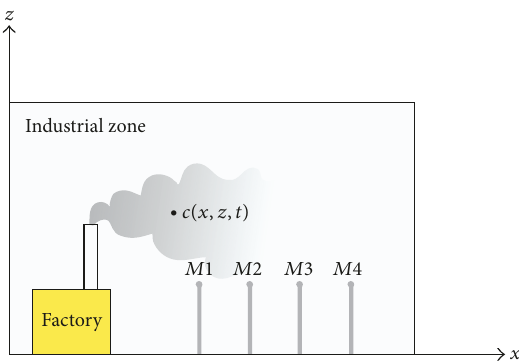
Figure 1: Model of air pollution emission control problem.